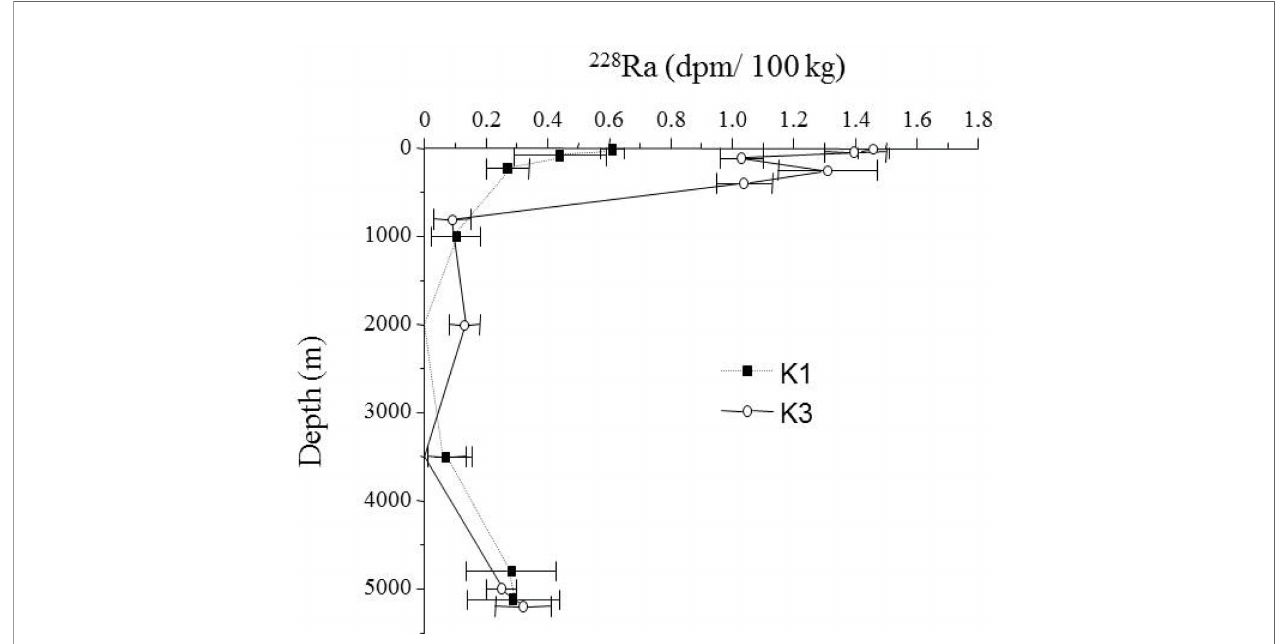
FIGURE 9 | Vertical pro fi les of dissolved 228 Ra activities determined at stations K1 and K3 in the North Paci fi c. The large difference in 228 Ra activities the upper 500 m between stations K1 and K3 is attributed to the extension of the Kurushio current that reached station K3 in year 2002 during the present